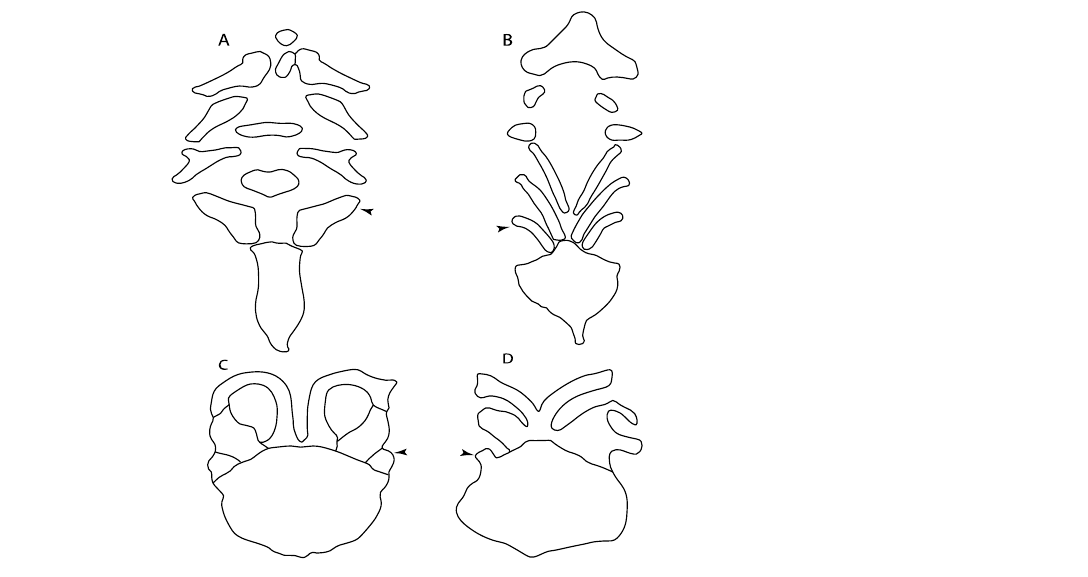
Figure 25. Interpretative drawings of basibranchial and hypobranchials in ventral view. State (0): ( A ) Callorhinchus capensis (ANSP 174852) redrawn and modified from de Carvalho et al. Text-Figure 9A in [99]; ( B ) Hemiscyllium ocellatum (AMNH 38151) redrawn and modified from de Carvalho et al. Text-Figure 9E in [99]. State (1): ( C , D ) Zapteryx exasperata (CNPE-IBUNAM 20528), † Spathobatis moorbergensis (BHN 2Pl) redrawn and modified from Cavin Text-Figure 4 in [100] Arrowhead: fourth hypobranchial.